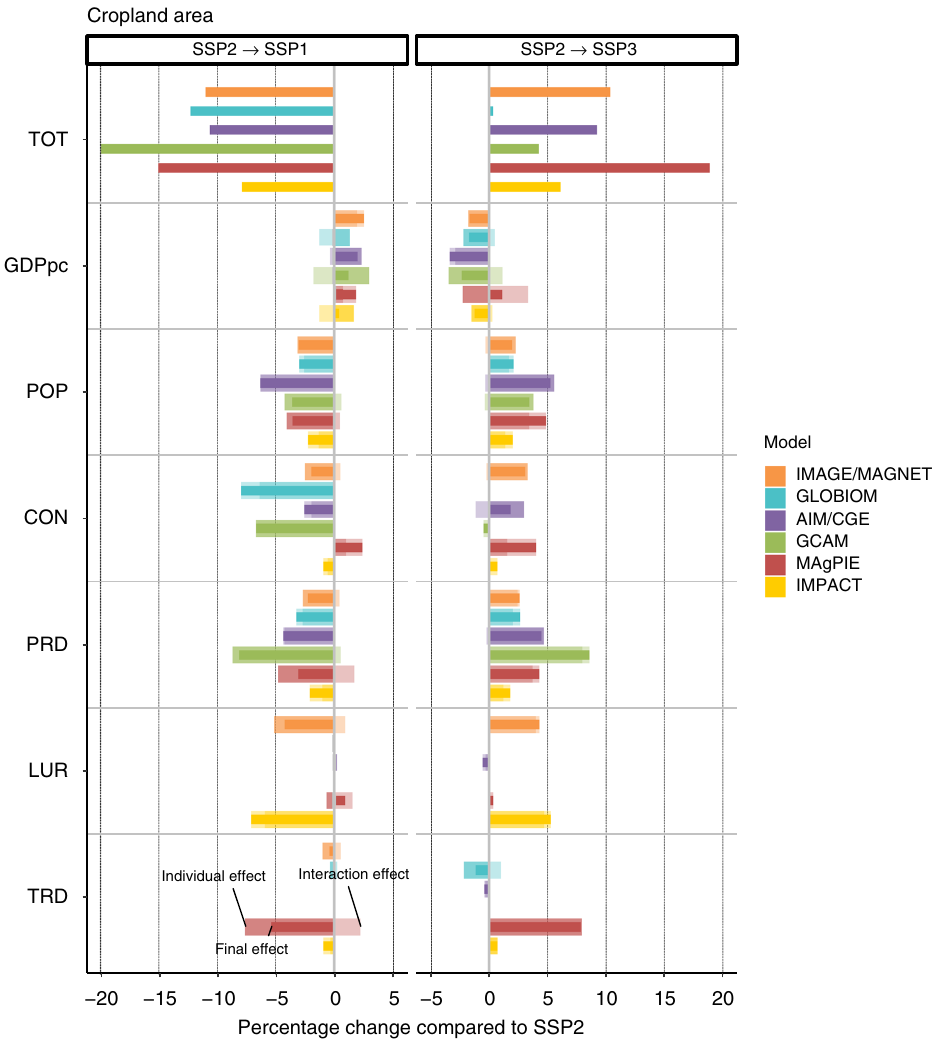
Fig. 2 Sensitivity of cropland area to groups of drivers. Changes refer to change in cropland area in 2050 when moving from SSP2 to either SSP1 (SSP2- > SSP1) or SSP3 (SSP2-> SSP3). Individual effects (wide, light-colored bars), fi nal effects (thin, dark-colored bars), and interaction effects (wide, very-light- colored bars) are shown for each of the six driver groups (CON: consumption preference, GDPpc: economic development, LUR: land-use regulation, POP: population, PRD: agricultural productivity growth, TRD: trade development), together with the total difference between SSP1 and SSP3, respectively, and SSP2 (TOT). The factor CON in MAgPIE also includes restrictions to irrigation (see Supplementary Information, Driver